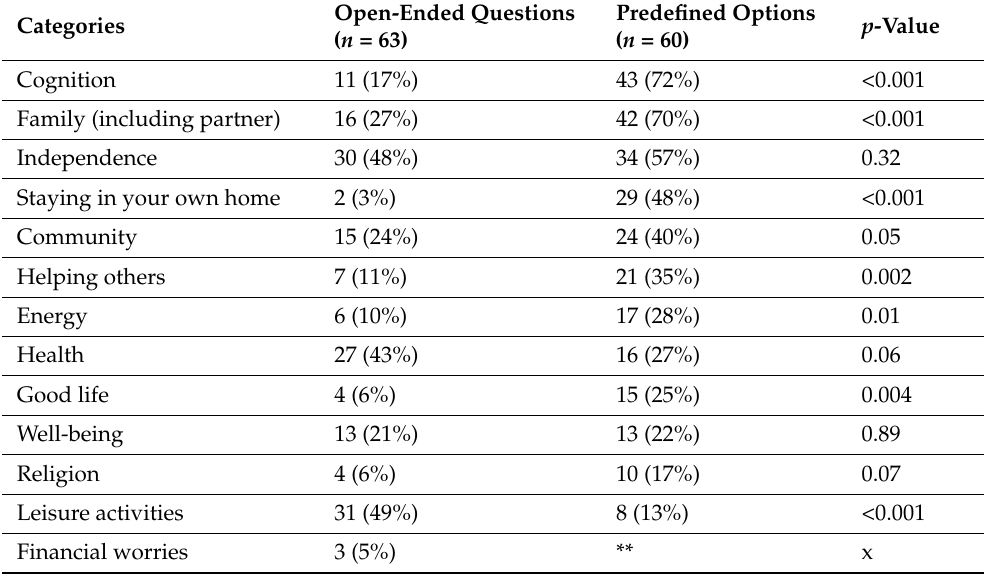
Figure 1. Open ended questions. Proportion of participants mentioning each domain of a question: What makes life worthwhile? What defines quality of life for you? What could affect (improve or decrease) your quality of life? Table 3. Selection of categories in predefined answer options vs. open-ended question regarding quality of